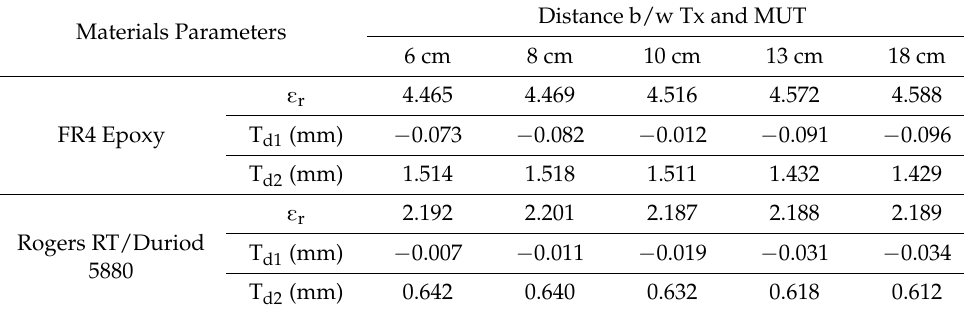
Table 1. Summary of Single-layer Material